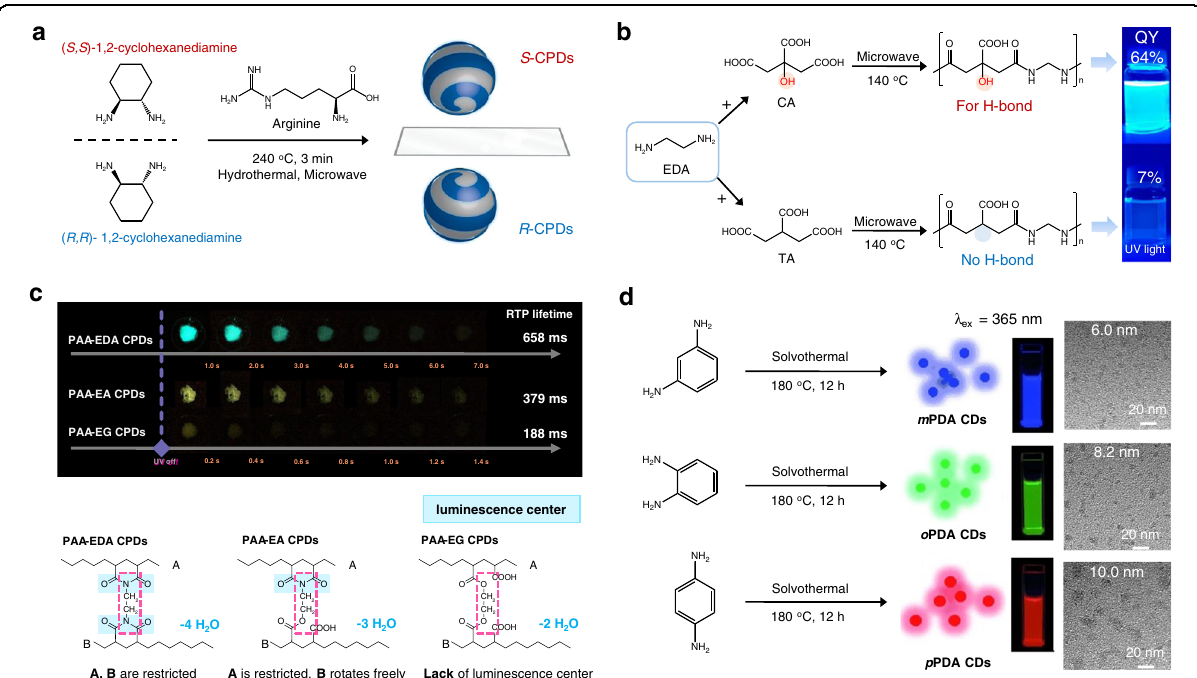
Fig. 2 Precursor-dependent emission. a Example of the direct synthesis of chiral CPDs from chiral diamine precursors. b Reaction of EDA with CA and TA to form CA-EDA CPDs and TA-EDA CPDs. c Precursor-dependent RTP property (top) and schematic representation of crosslinking sites (bottom) present in PAA-EDA, PAA-EA, and PAA-EG CPDs. d Preparation of RGB PL CPDs from three different phenylenediamine isomers. Reprinted with permission from the literature reports 13,44,51,52 . Copyright 2019 Nature Publishing Group, 2018 American Chemical Society, 2018 Wiley – VCH, 2015 Wiley –